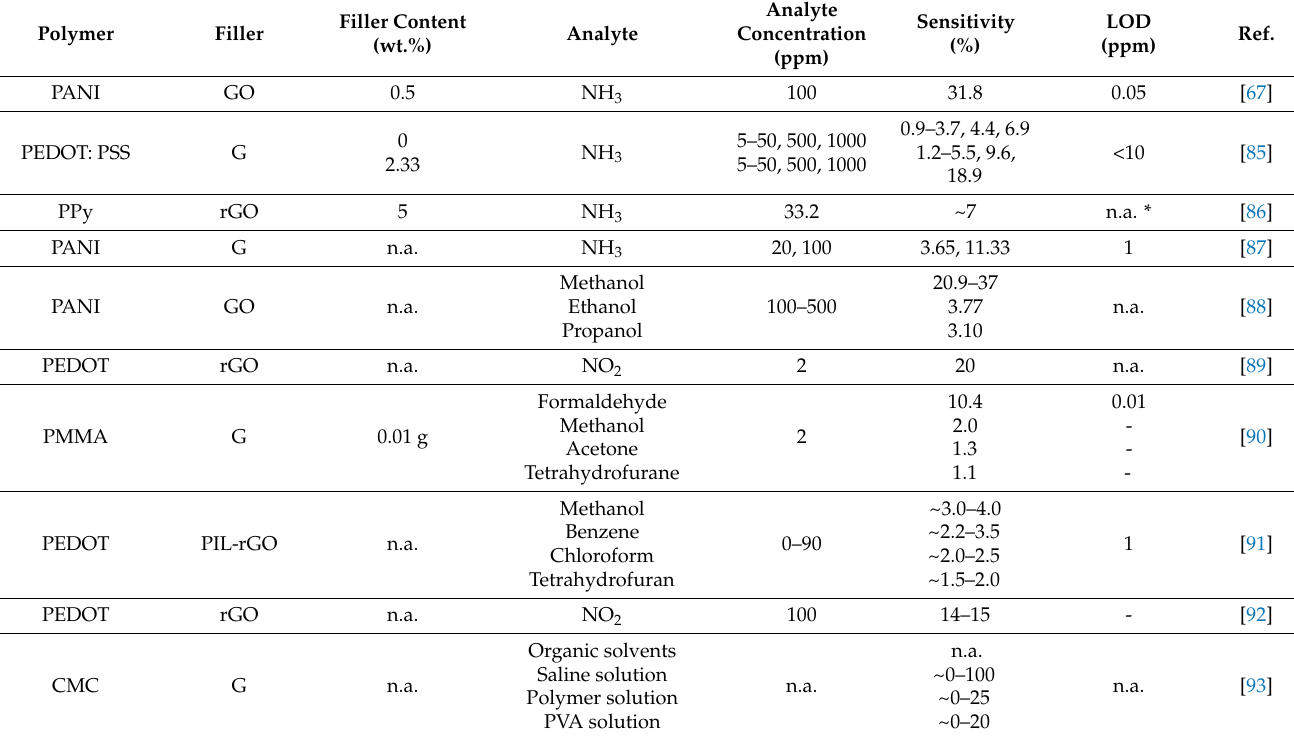
Table 2. G, GO, rGO/polymer nanocomposite films as chemiresistive sensors.